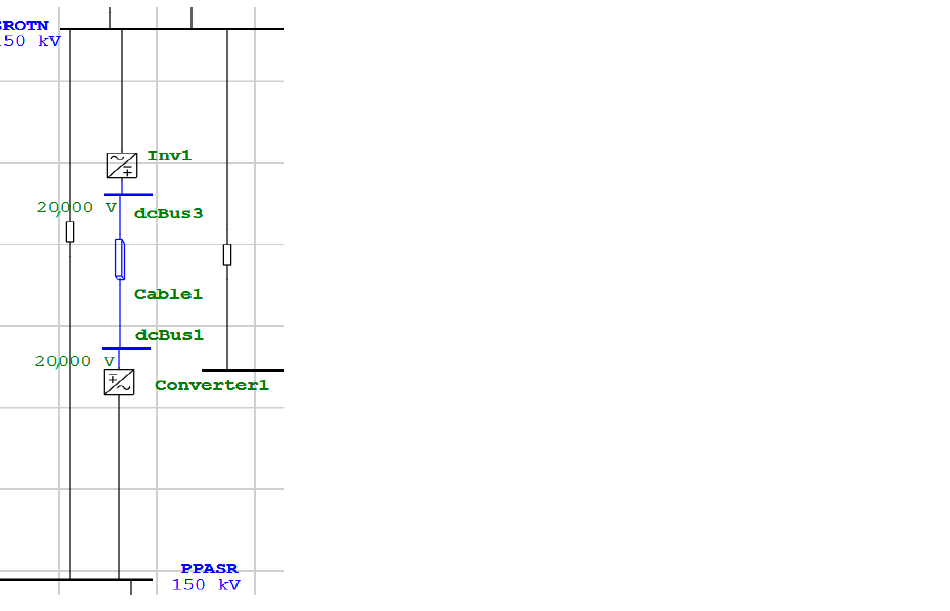
The calculation of the rectifier-inverter transformer rating on the 150 kV Paya Pasir